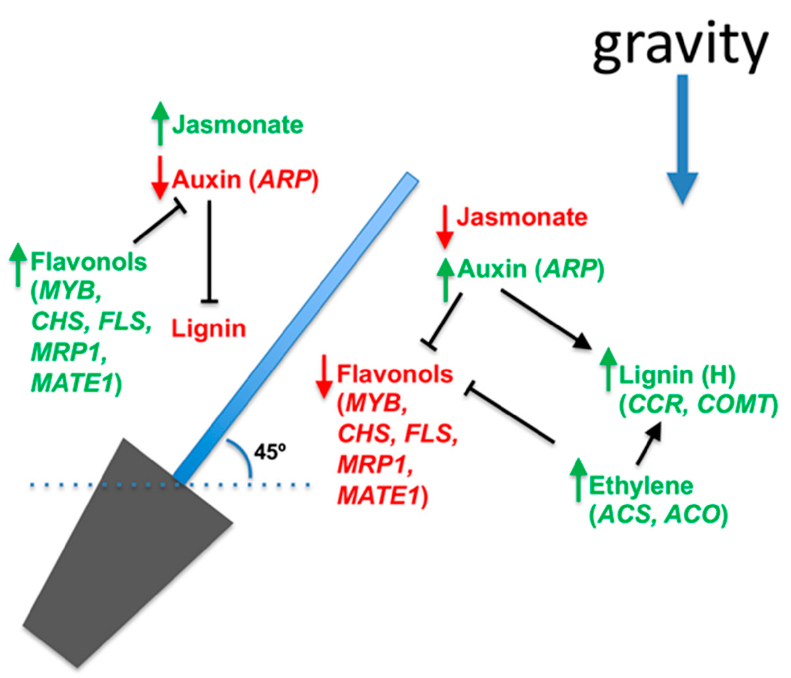
Figure 1. Summary of hormonal distribution, genetic expression profile, and metabolic differential accumulation in gymnosperms exposed to inclination. Auxin-Repressed Protein (ARP), chalcone synthase (CHS), flavonol synthase (FLS), cinnamoyl-CoA reductase (CCR), caffeic acid O-methyltransferase (COMT), MYB transcription factors, flavonoid transporters as ABCC-flavonoid transporter (multidrug transporter protein 1 (MTR1) and multidrug and toxic extrusion 1 (MATE1) are genes differentially expressed on both sides of the inclined stem of radiata pine. Auxin content, ethylene as wells as ethylene biosynthesis genes (ACC synthase [ACS] and ACC oxidase [ACO]), and jasmonate content are differentially distributed on both sides of the inclined stems and regulate the differential expression of genes involved in lignin and flavonol biosynthesis (based on Salazar et al. (2020) [23], Ramos et al. (2016) [32], Klintborg et al. (2002) [28], Little and Eklund (1999) [26], Ramos et al. (2012) [30], Ramos and Herrera (2013) [31], Gomez et al. (2018) [88], Morales-Quintana et al. (2019)